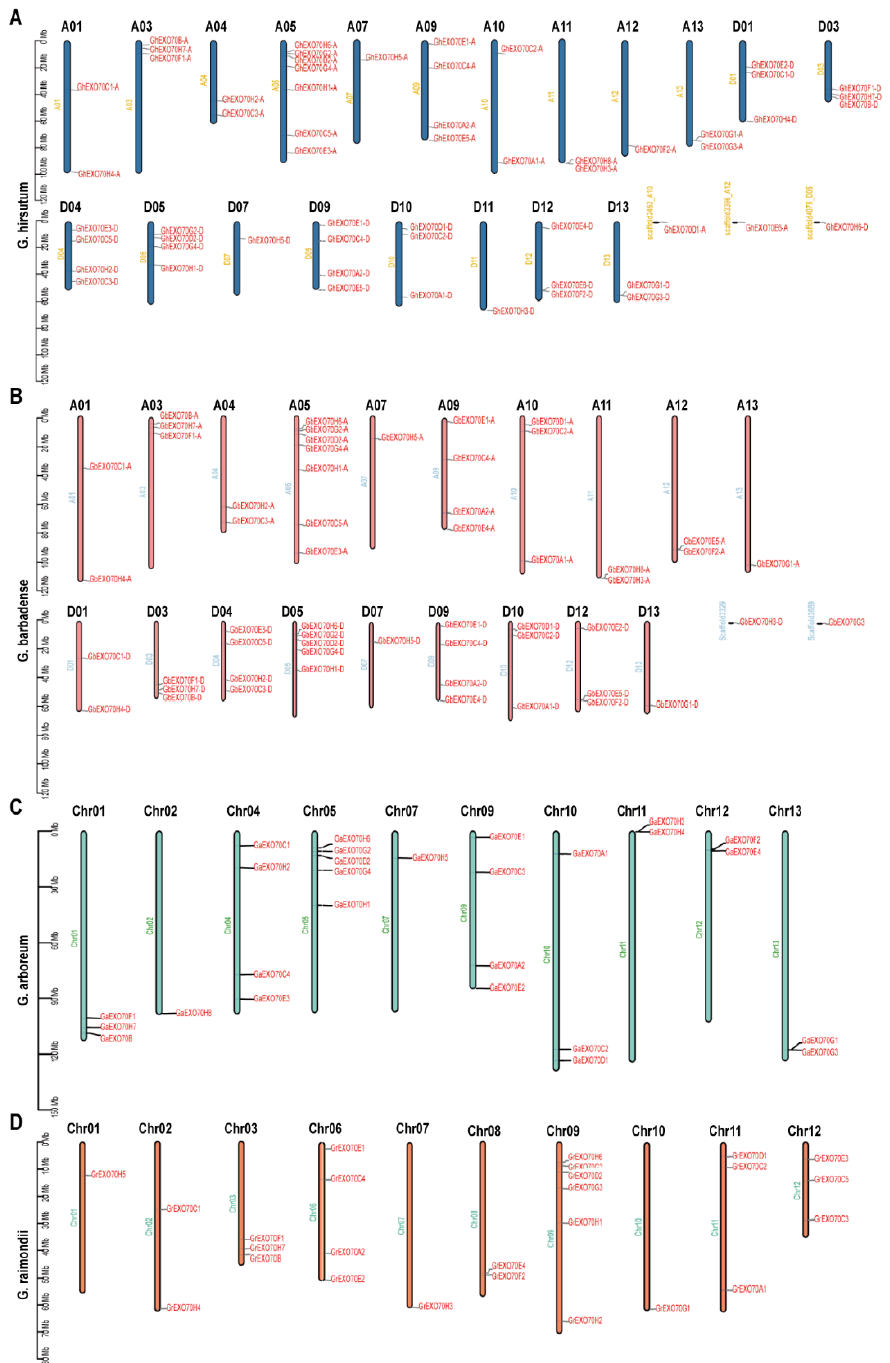
Figure 2. Chromosome distributions of EXO70 in upland cotton, sea island cotton, Asian cotton, and Raymond cotton. ( A ) Chromosome distribution map of EXO70 in upland cotton. ( B ) Chromosome distribution map of EXO70 in sea island cotton. ( C ) Chromosome distribution map of EXO70 in Asian cotton. ( D ) Chromosome distribution map of EXO70 in Raymond cotton.